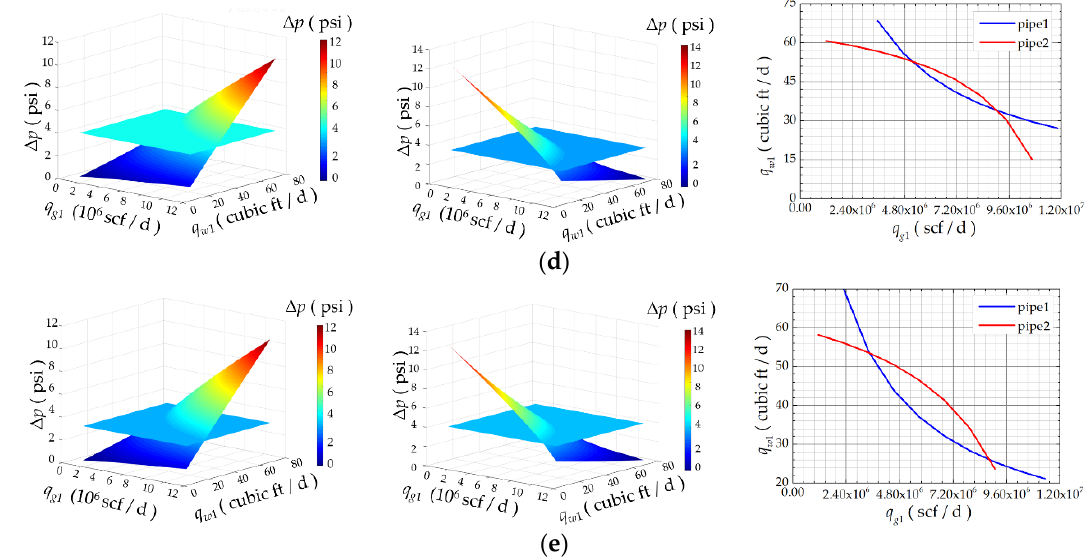
Figure 12. Obtaining the reasonable flow rate pairs of the first 5 days: ( a ) 1st day; ( b ) 2nd day; ( c ) 3rd day; ( d ) 4th day; ( e ) 5th day.